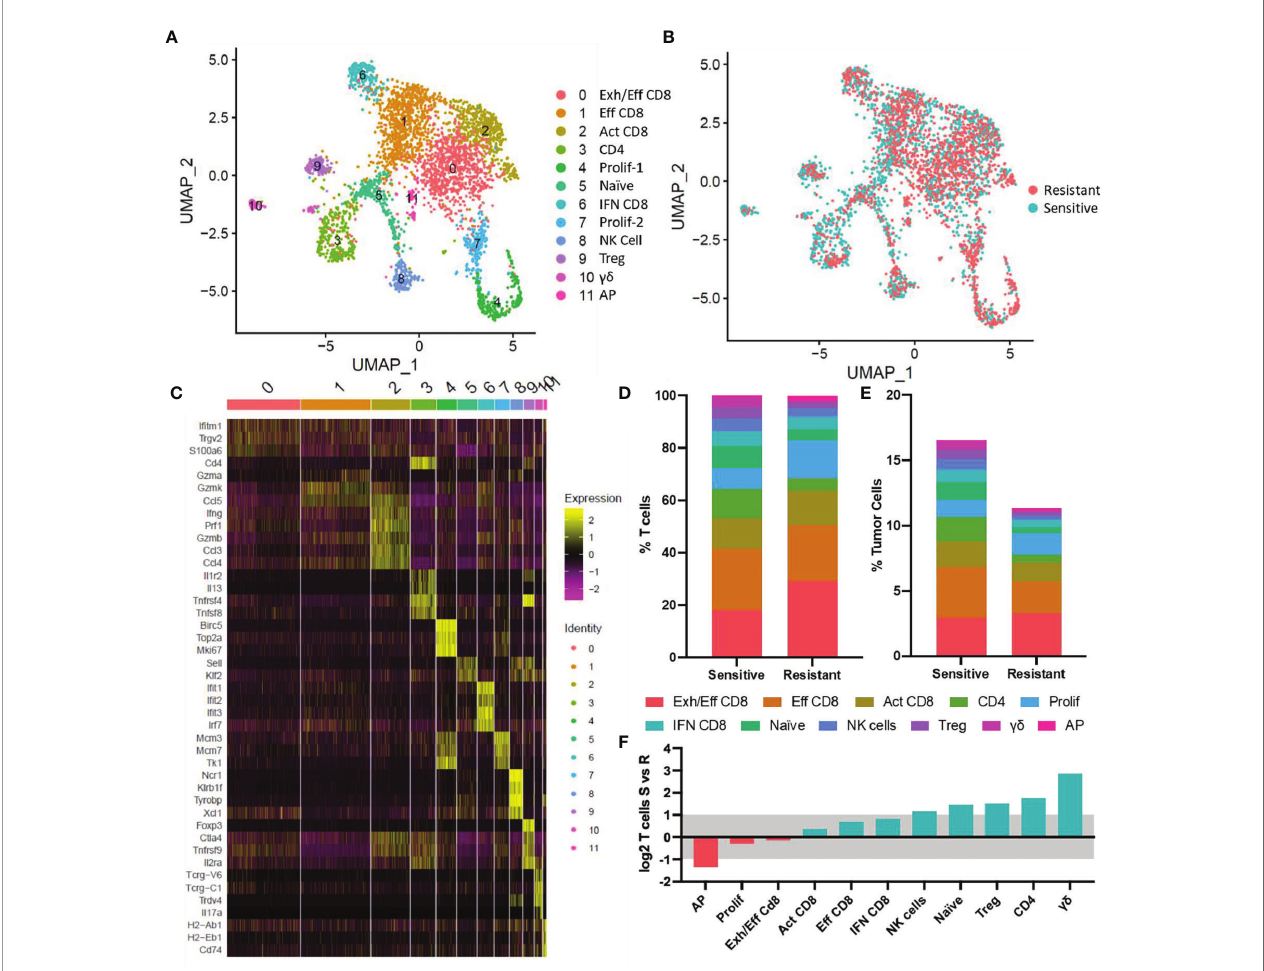
FIGURE 3 | ScRNA-Seq of tumor in fi ltrating T cells. (A) UMAP plot of tumor in fi ltrated T cells. 12 populations identi fi ed via transcriptional pro fi les are denoted by color. (B) UMAP plot with colors denoting tumor response to DOX. (C) Heat map showing relative gene expression for genes of interest per cell in each cluster. (D) Distribution of T cell subtypes in sensitive and resistant tumors. (E) Normalized T cell subtype abundance in sensitive or resistant tumors relative to all tumor cells. (F) Shifts in abundance of tumor in fi ltrating T cells in sensitive and resistant tumors. Blue bars denote populations with increased abundance in sensitive tumors, red bars denote populations increased in resistant tumors. Bars outside the grey shaded region represent signi fi cant (>2-fold) shifts in cell type abundance. Exh/Eff CD8, exhausted effector CD8 T cells; Eff CD8, effector CD8 T cells; Act CD8, activated CD8 T cells; CD4, CD4 T cells; Prolif-1, proliferating T cells-1; Naïve, naïve T cells; IFN CD8, interferon stimulated CD8 T cells; Prolif-2, proliferating T cells-2; NK Cell, natural killer cells; Treg, T regulatory cells; gd , gd T cells; AP, antigen presenting T